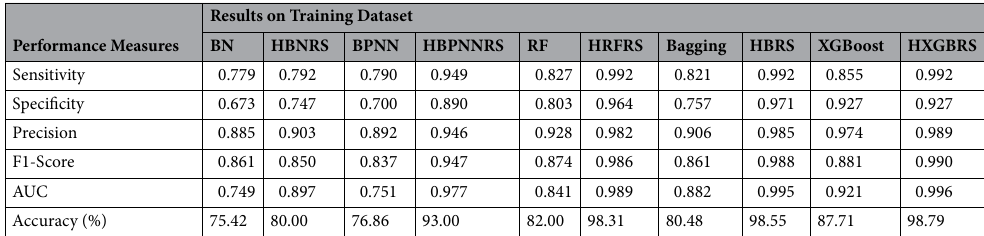
Table 4. Performance comparison of various base, ensemble and hybrid landslide prediction models on training dataset using statistical parameters based on confusion